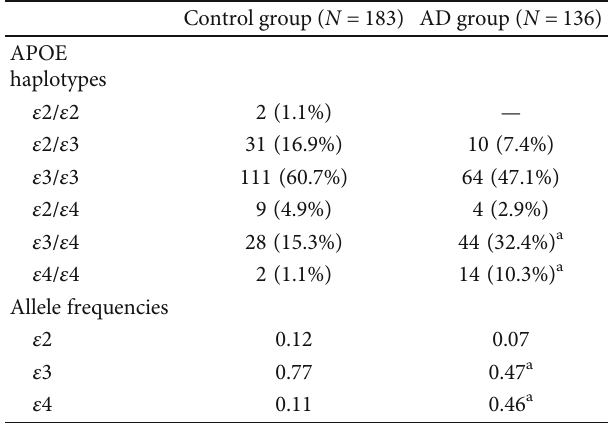
Table 2: Frequency distribution of haplotypes and alleles of APOE. Control group ( N = 183 ) AD group ( N = 136